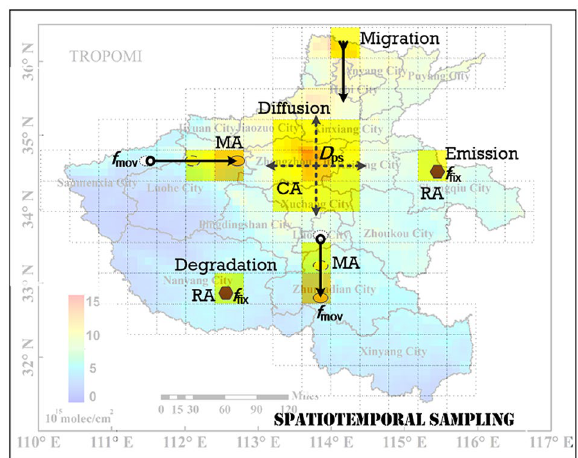
Figure 2. The pollutants emission, migration, diffusion and degradation between CA, MA and RA in SI-APSTE